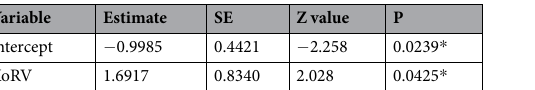
Table 3. Estimate and standard error (SE) of the explanation variables in the final model following backwards selection of the binary logistic